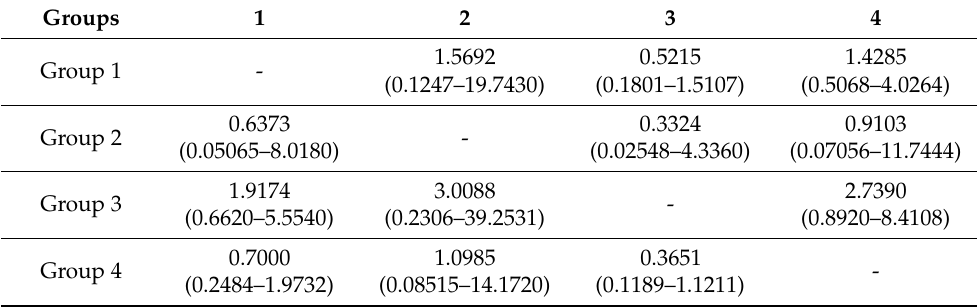
Table 3. Hazard ratios (HR) with 95% confidence interval for PFS.